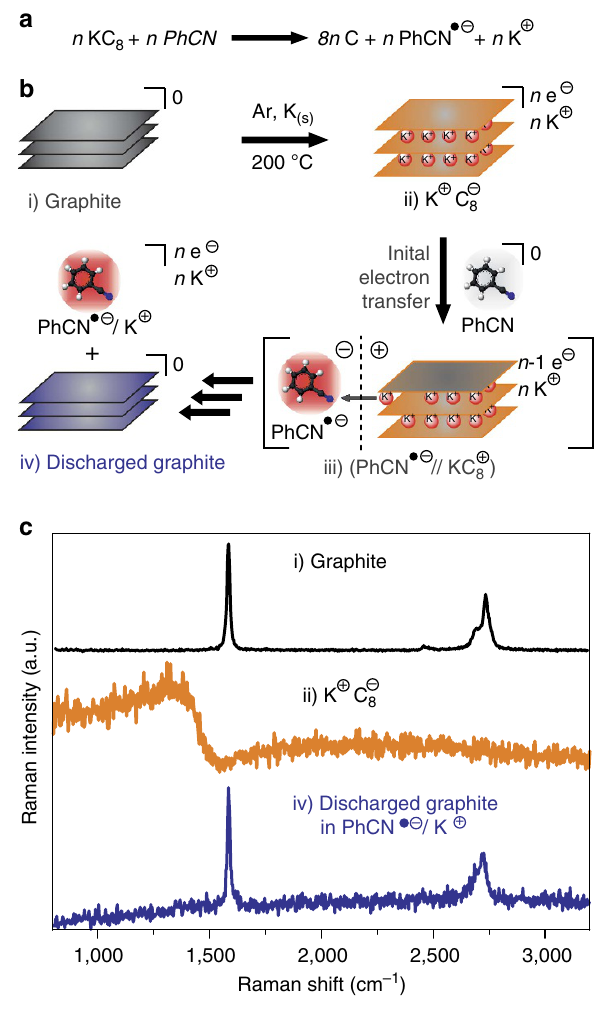
Figure 2 | Charging and discharging of graphite. ( a ) Reaction equation for the reaction of KC 8 with benzonitrile under inert gas atmosphere. ( b ) Reaction scheme: After graphite (i) and solid potassium are melted to (ii) KC 8 , the addition of benzonitrile (PhCN) leads to an initial electron transfer from the GIC onto the PhCN. The so formed PhCN (cid:3) (cid:2) anion and the resulting Coulomb attraction to the initially oxidized (iii) KC 8 þ is followed by deintercalation of K þ . After subsequent oxidation and K þ migration, the (iii) fully discharged graphite is obtained while all charges are quantitatively transferred into the benzonitrile solution phase. ( c ) Raman spectra ( l exc ¼ 532nm) of the respective species in the GIC/benzonitrile cell being stable under inert gas for